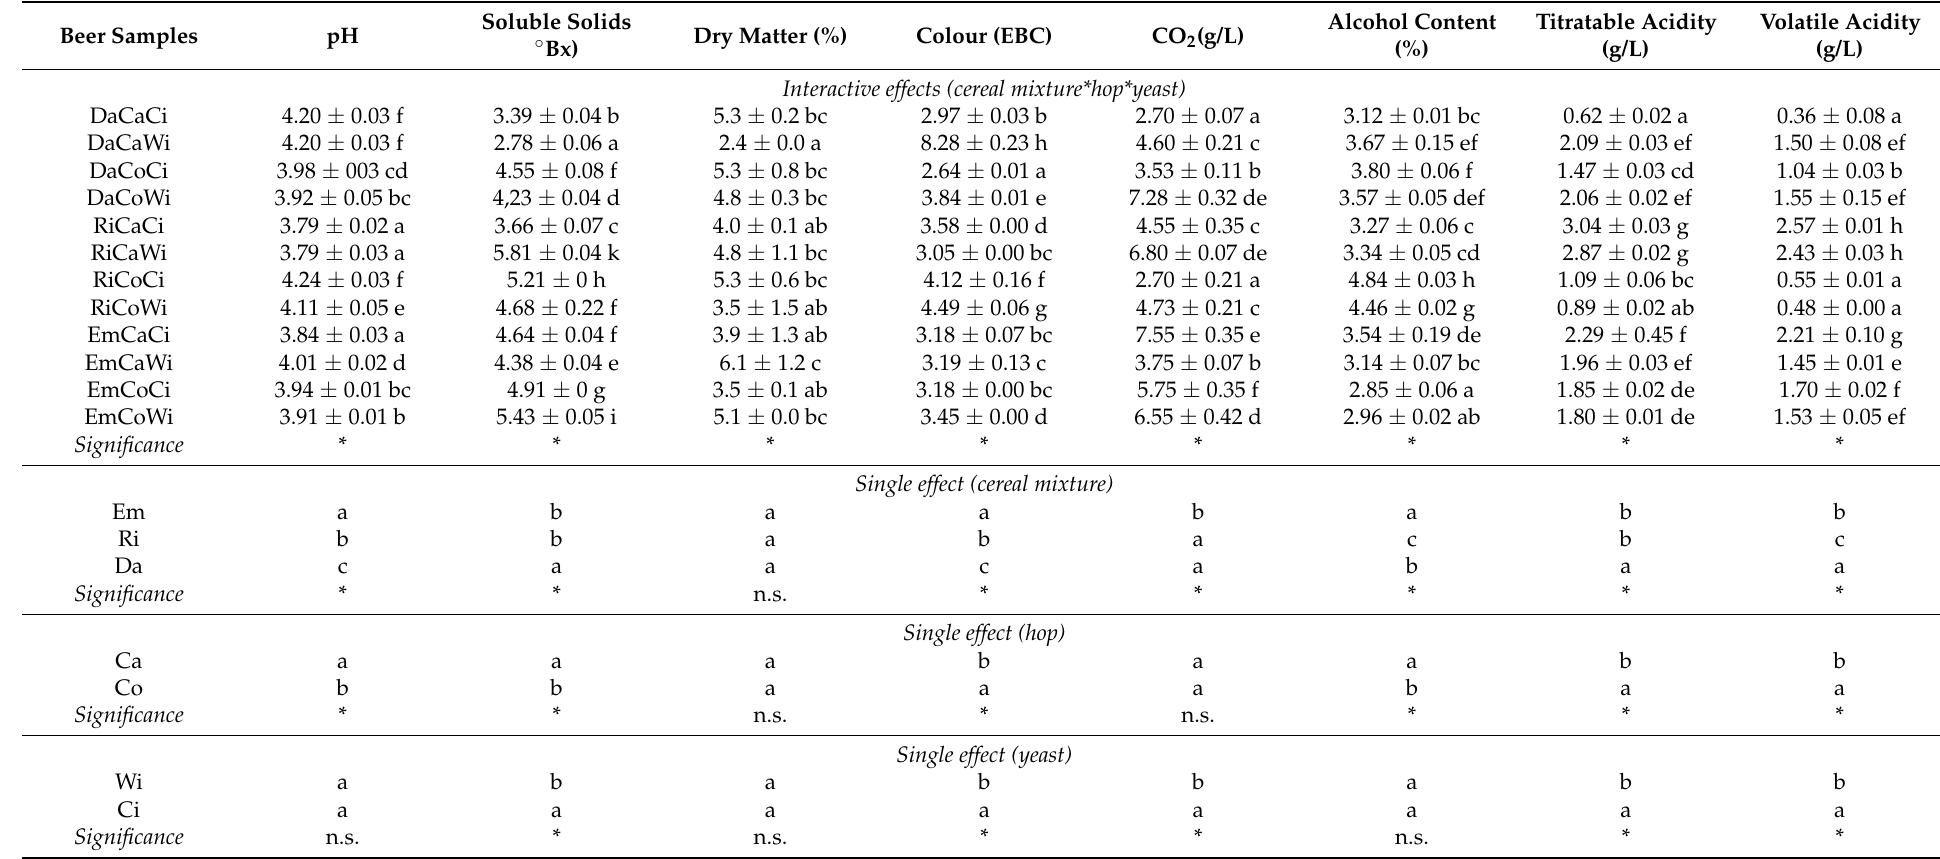
Table 3. Results of the basic analyses of beer samples. Single and interactive effects of cereal mixtures, hops, and yeasts used in